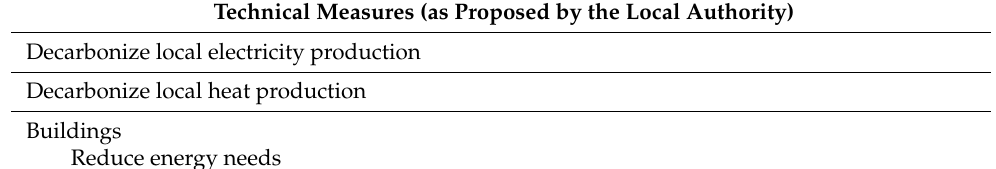
Table 6. Technical measures proposed in the Sustainable Energy Action Plan (SEAP) Malmö. Technical Measures (as Proposed by the Local